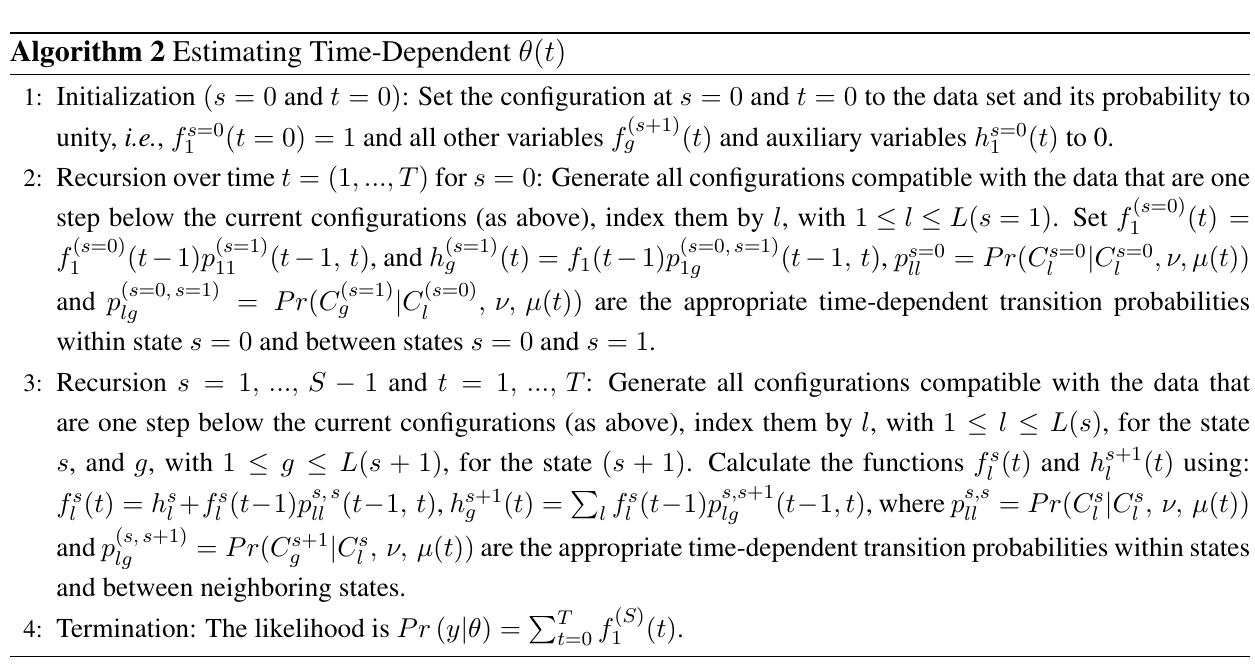
Algorithm 2 Estimating Time-Dependent θ ( t